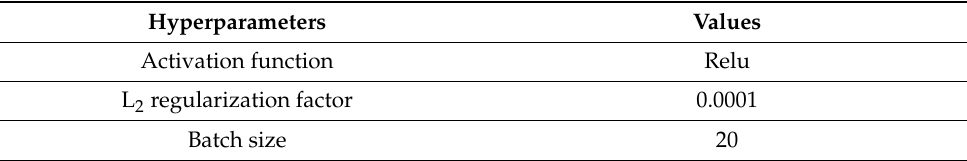
Table 3. Optimized DNN model for path loss